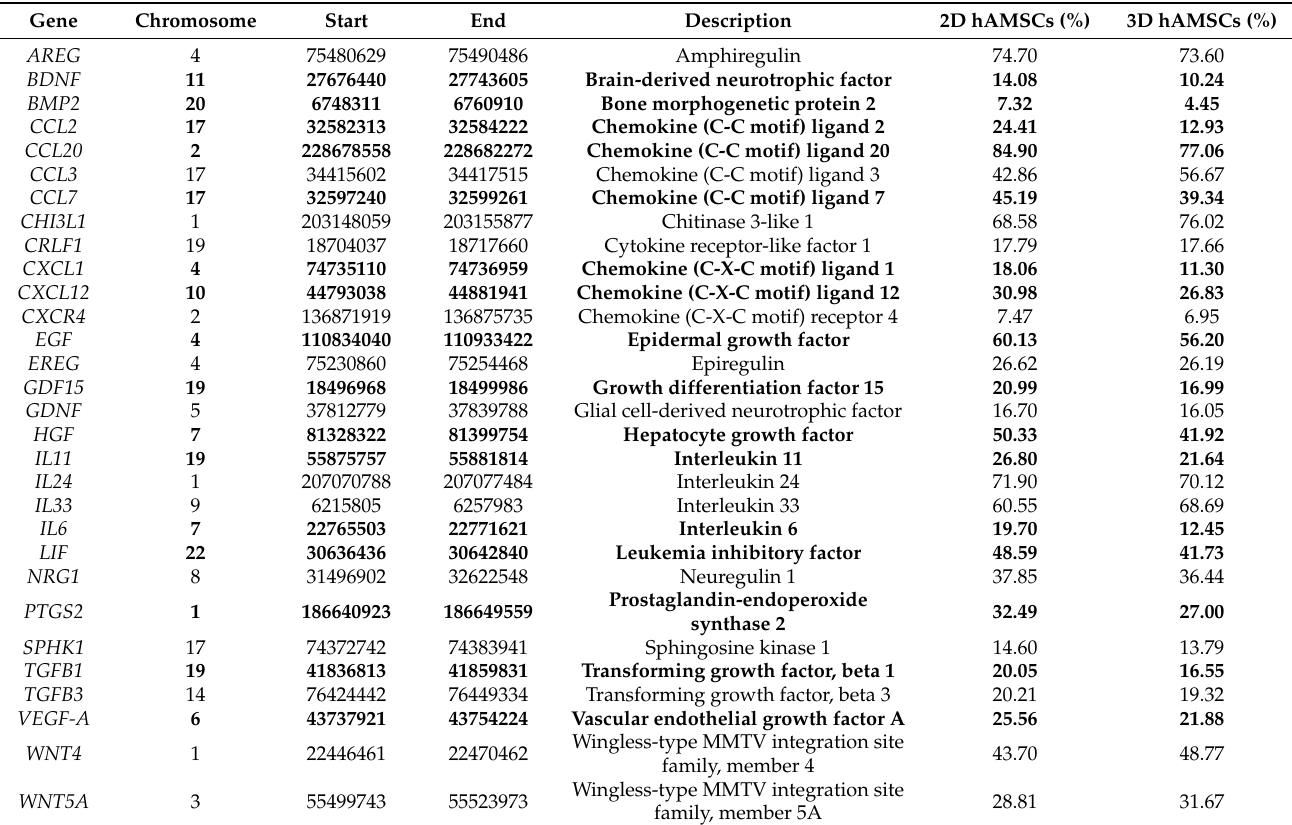
Table 1. Methylation levels (all sites) of upregulated genes in 2D and 3D hAMSCs.